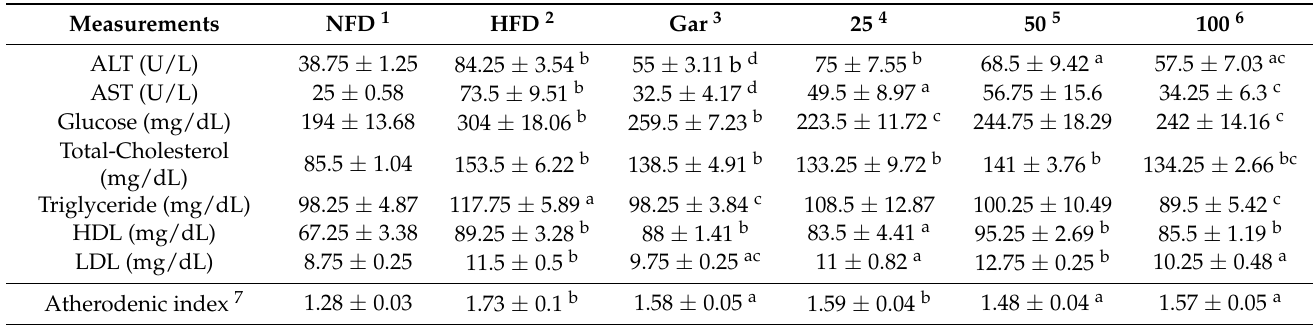
Table 2. Measurement of blood biochemical